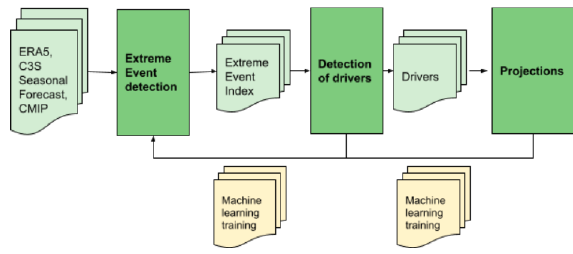
Figure 5. Scheme of the development of the service based on machine learning that performs a) detection of heatwaves, b) detection of drivers leading heatwaves, and c) projections of heatwaves using different datasets and